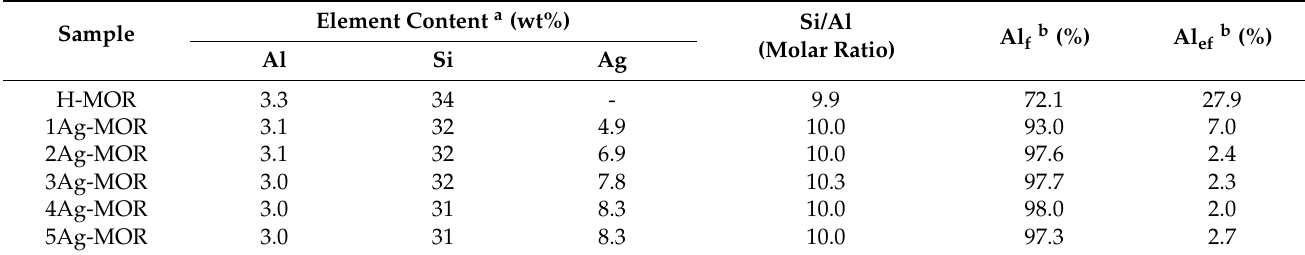
Table 2. Chemical compositions of